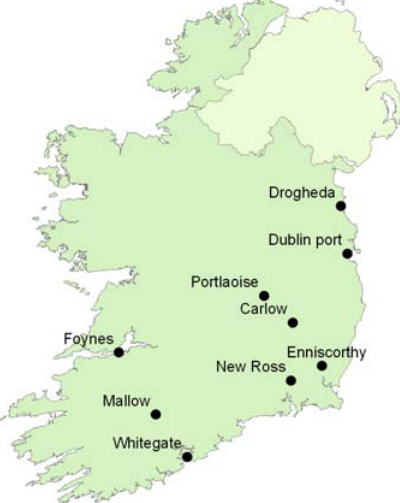
Figure 1 . Locations of the final nine potential bioethanol plant locations